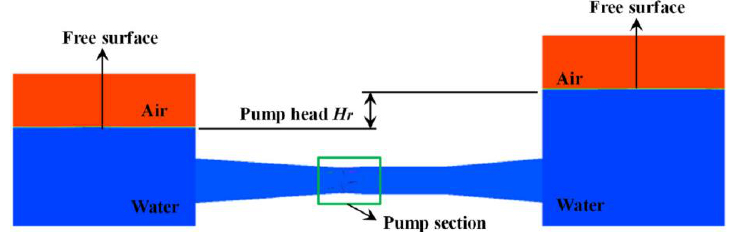
Figure 30. The initial flow field of the calculated domain [35].